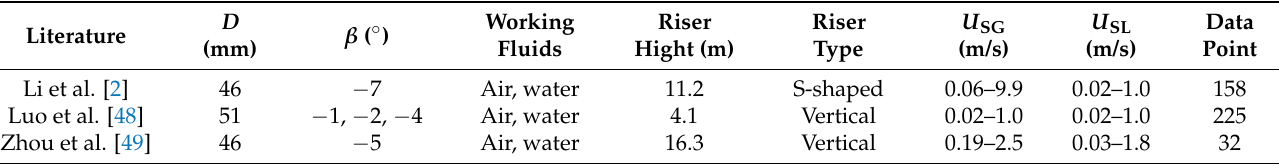
Table 1. Conditions of experimental data